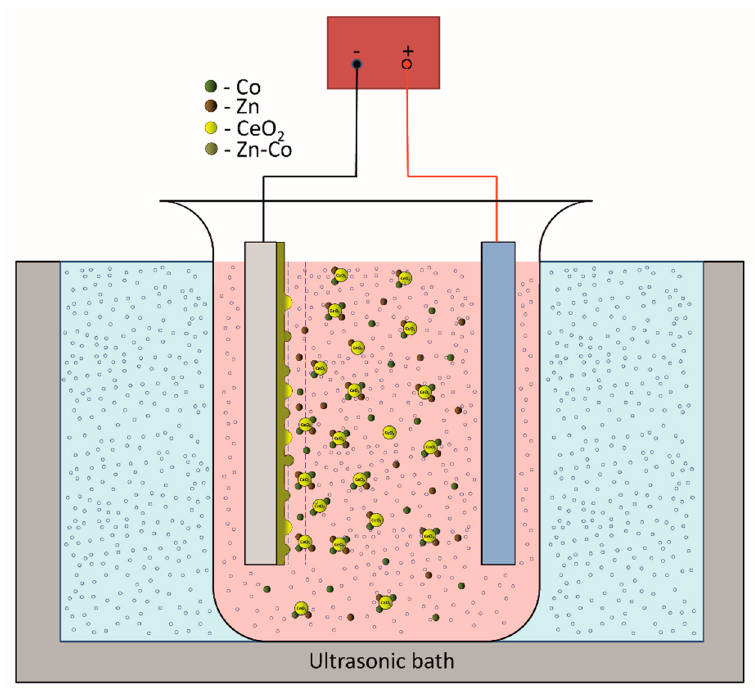
Figure 1. Schematic presentation of the deposition